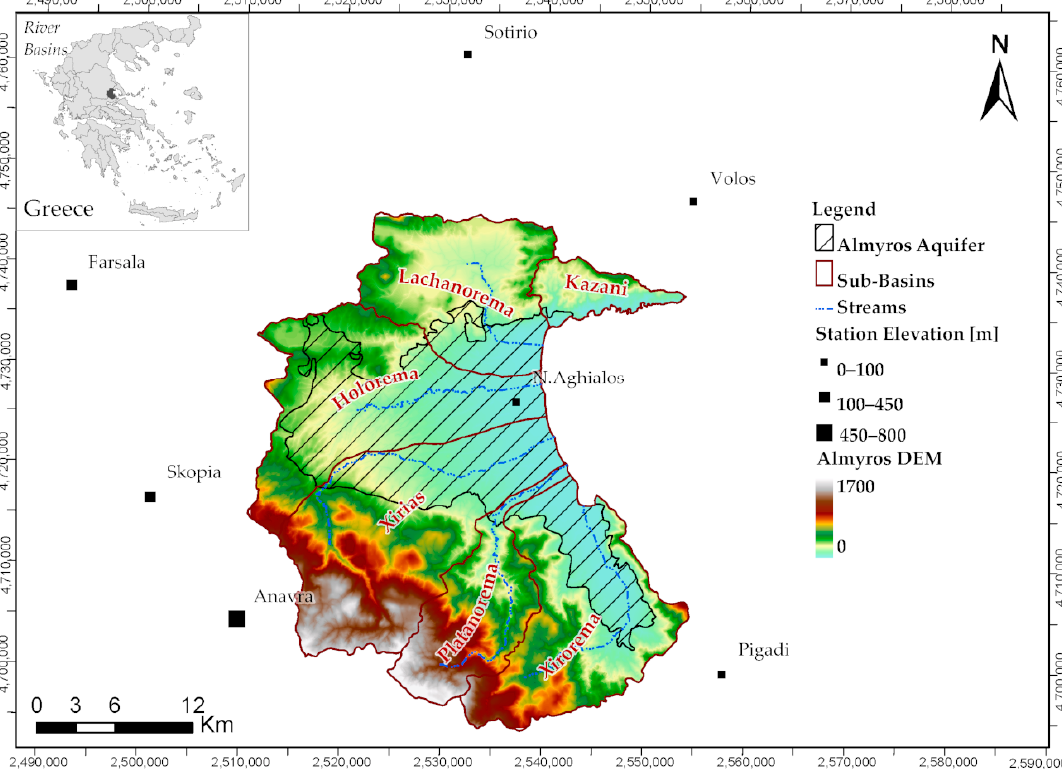
Figure 2. Almyros aquifer system, elevation and streams of sub-basins, and locations of weather stations.